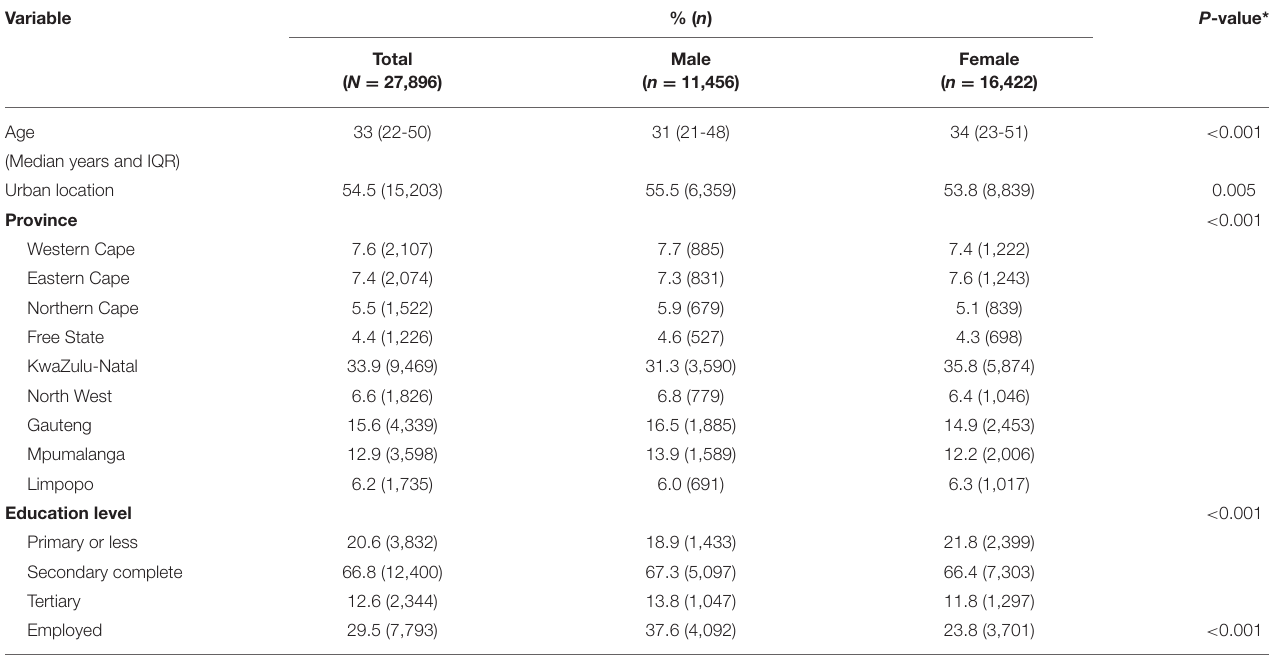
TABLE 1 | Description of sample by sex (unweighted).